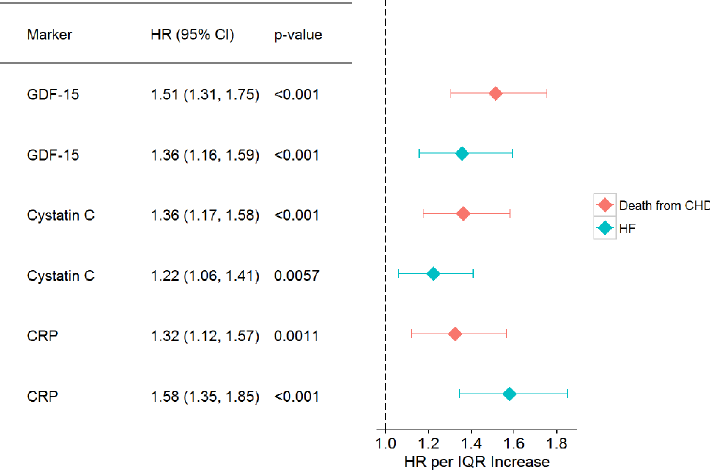
Fig 2. Biomarker hazard ratios for the endpoints death from CHD and incidence of HF. Cox models were adjusted for age (as the time scale), sex, overweight (BMI > 25 kg/m 2 ), systolic blood pressure, diabetes, daily smoker, renal insufficiency (eGFR > 60 ml/min or 1,73m 3 ). The biomarkers were used after being log-transformed. The follow-up time begins at round 1. Only round 1 measurements are used. IQR: interquartile range.